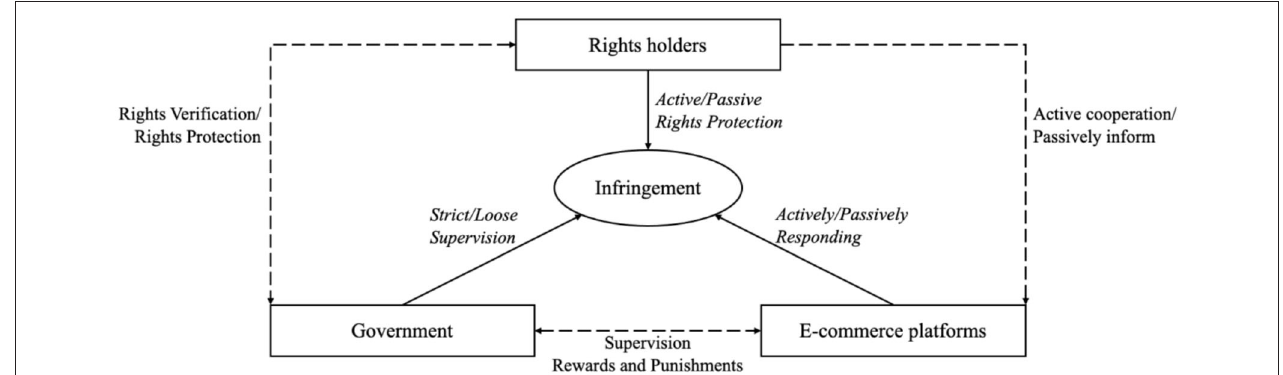
FIGURE 1 | System diagram of e-commerce intellectual property social co-governance.